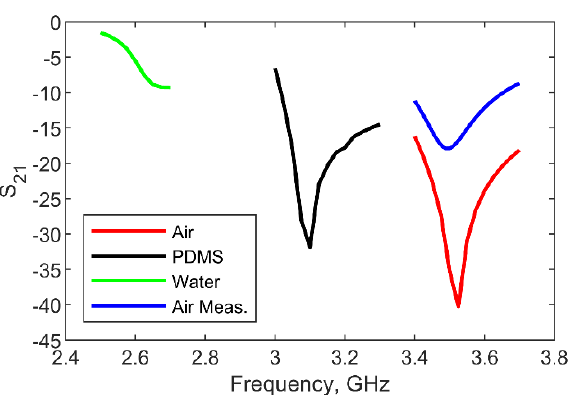
Figure 4. Simulated S-parameters of the CSRR covered by air, PDMS and microwell loaded with water, and measured CSRR covered by air without the PDMS slab.